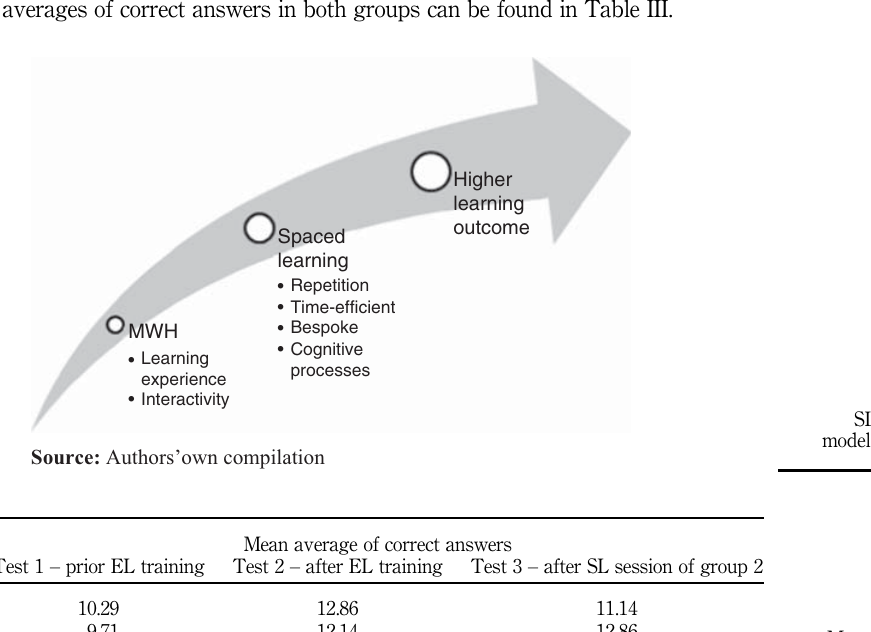
Table III. Mean average